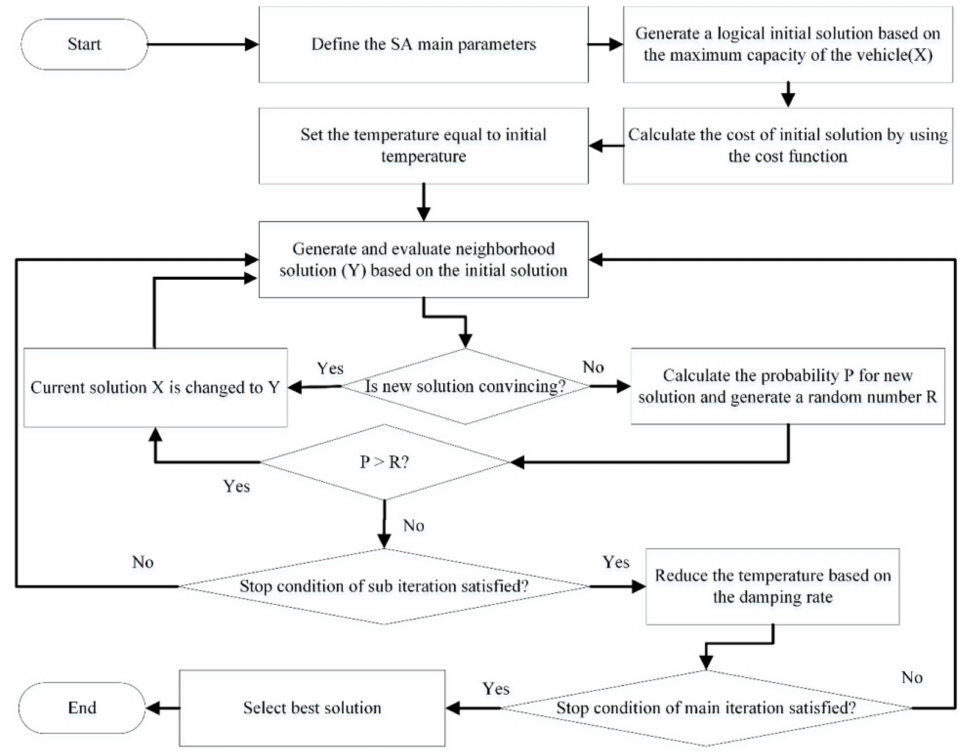
Figure 2. An overview of the simulated annealing algorithm.